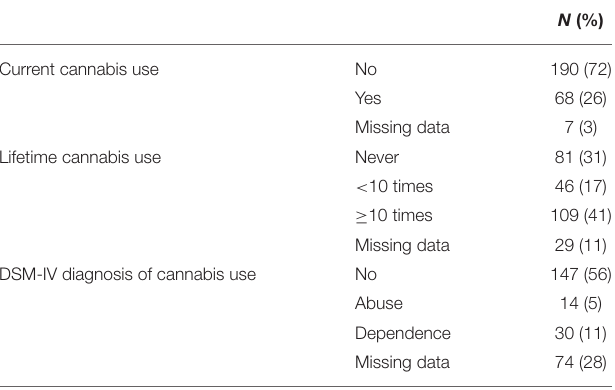
TABLE 1 | Cannabis use in the FTP patients.